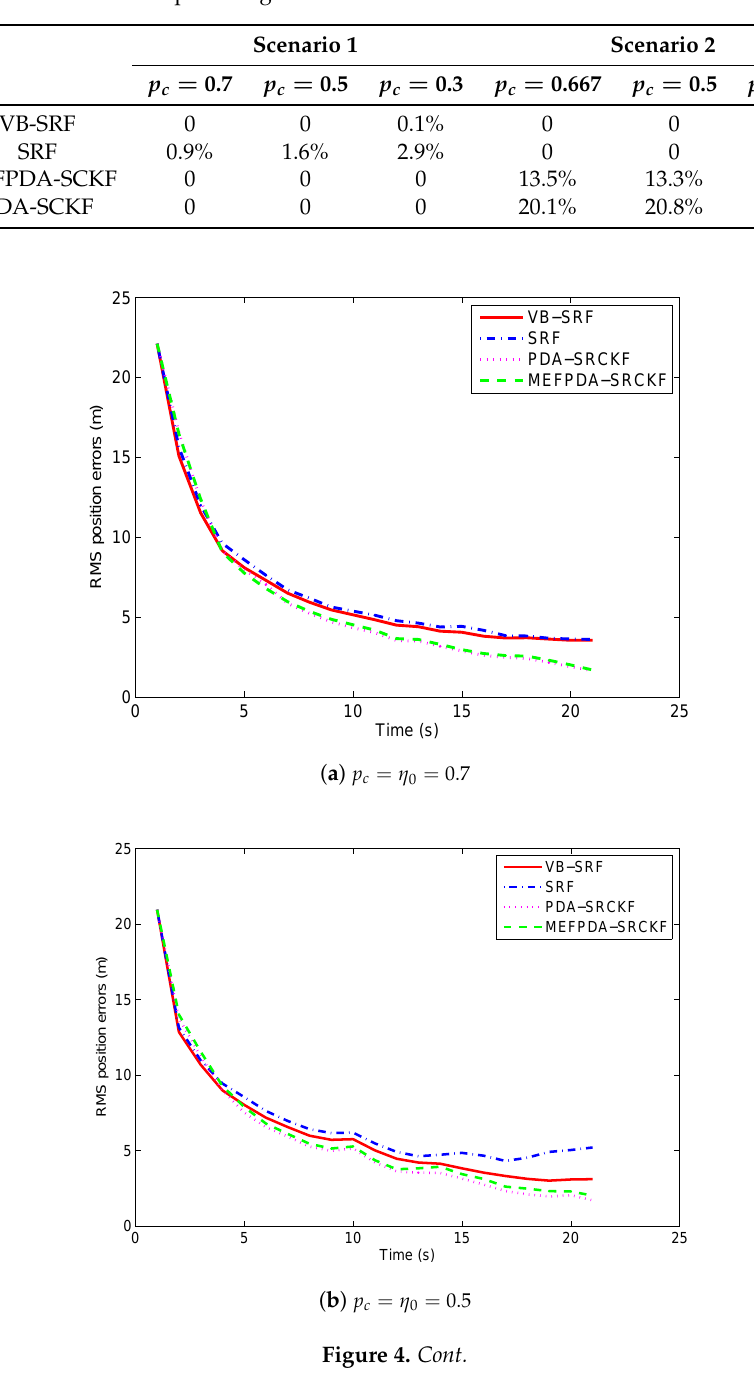
Table 1. The percentages of track losses of four filters in two scenarios.